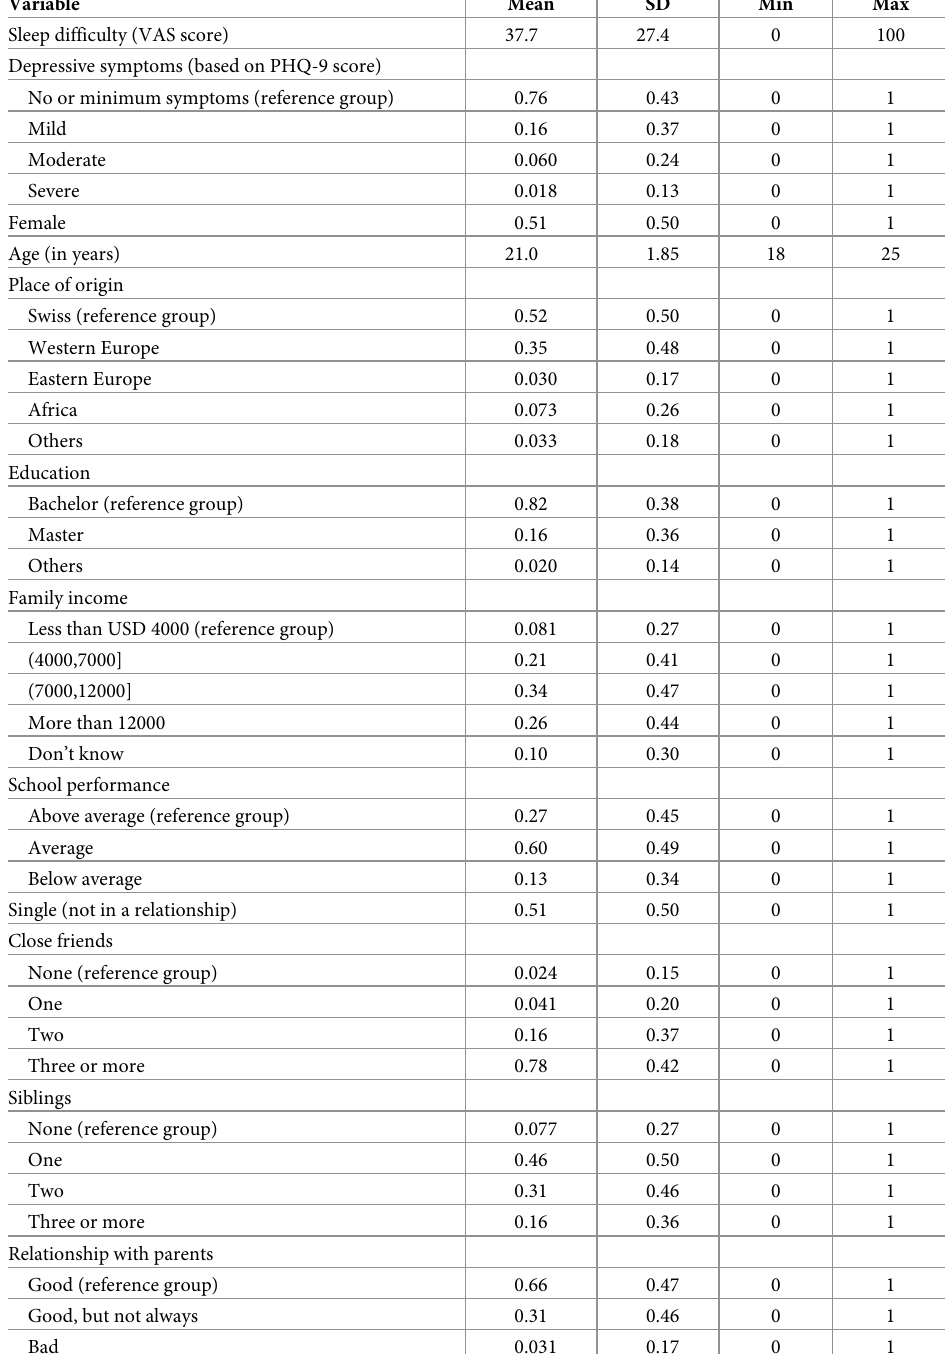
Table 1. Descriptive statistics ( N = 1,